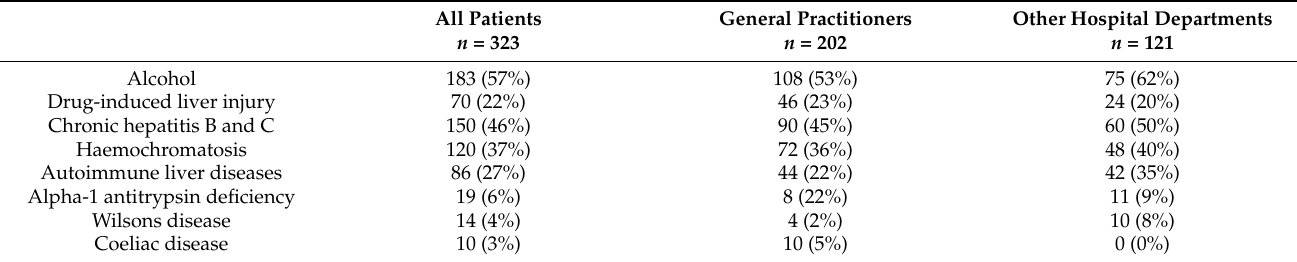
Table 2. Differential diagnoses excluded before referral to the Gastro Unit. The table shows the total number and % for all patients and patients referred from the primary and secondary sectors.